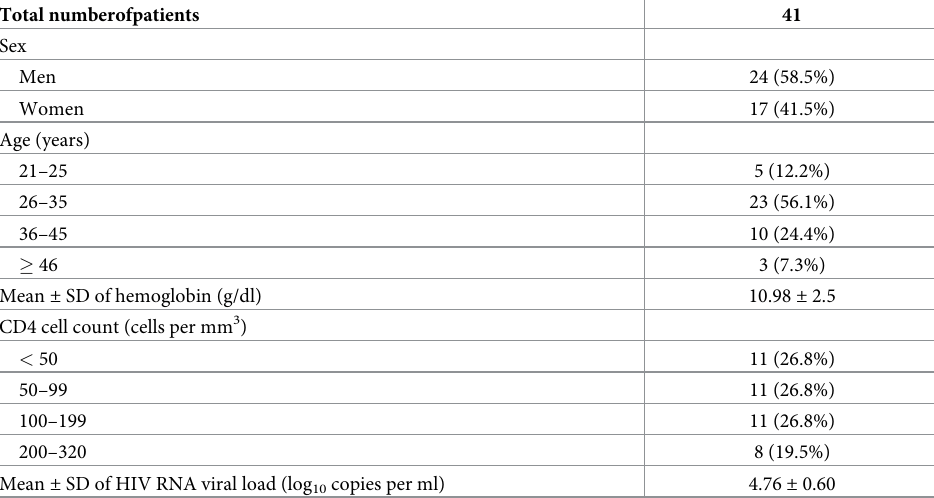
Table 1. Baseline characteristics of